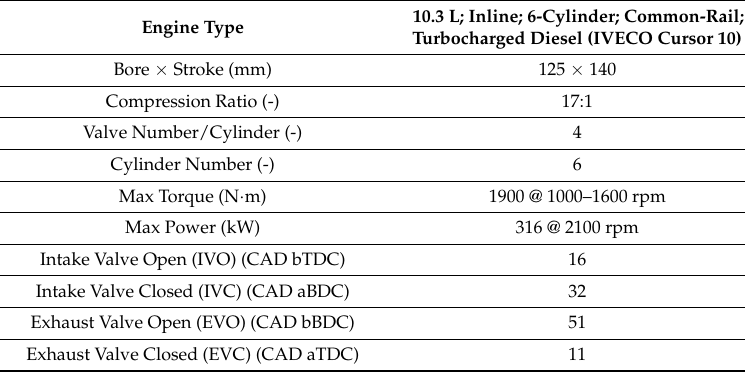
Table 1. Specifications of the modeled